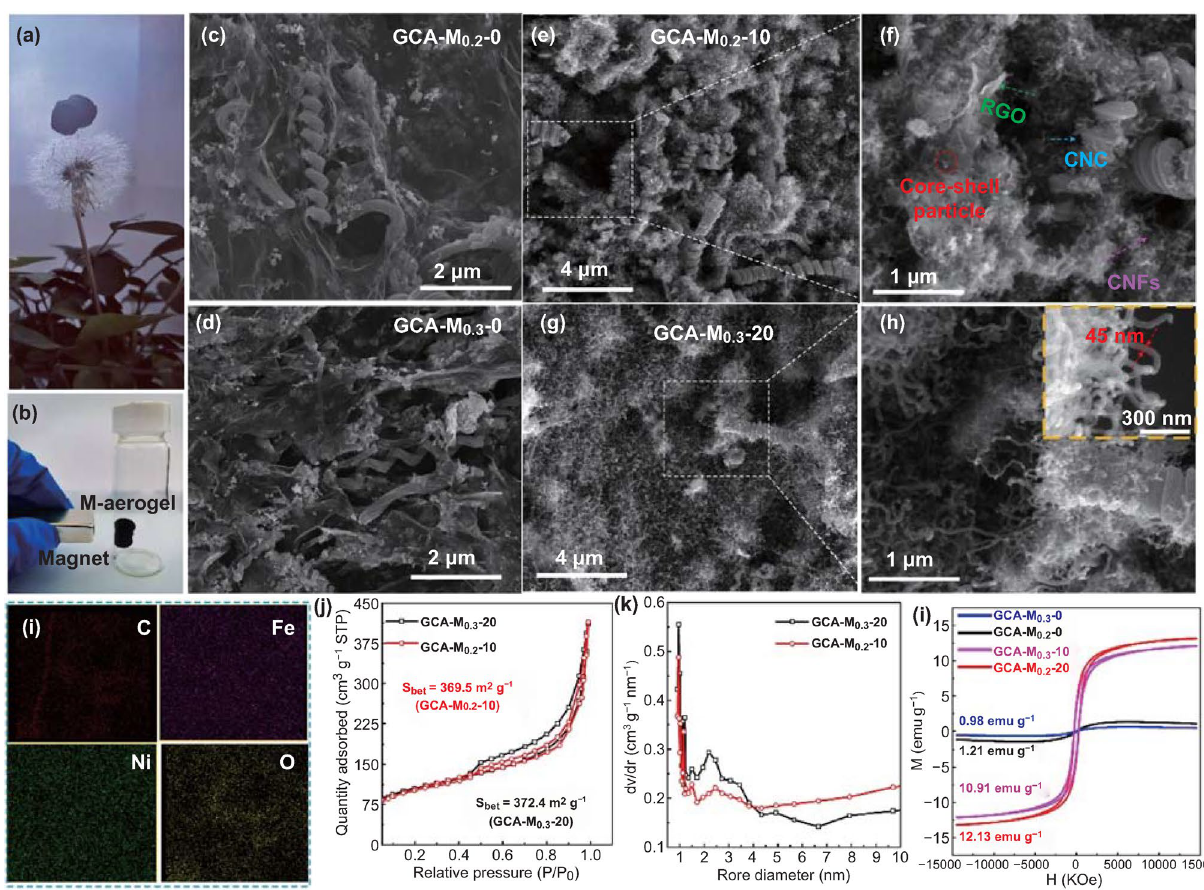
Fig. 2 As-obtained aerogel ( a ) standing on a dandelion, and ( b ) attracting by a magnet; The SEM images of ( c ) GCA–M 0.2 –0, ( d ) GCA–M 0.3 –0, ( e , f ) GCA–M 0.2 –10, and ( g , h ) GCA–M 0.3 –20, ( i ) elemental mappings of C, Fe, Ni, and O in GCA–M 0.3 –20. ( j ) N 2 adsorption/desorption iso- therms and ( k ) corresponding pore size distributions for the GCA–M 0.2 –10 and GCA–M 0.3 –20. ( l ) Magnetic hysteresis loops of GCA–M 0.2